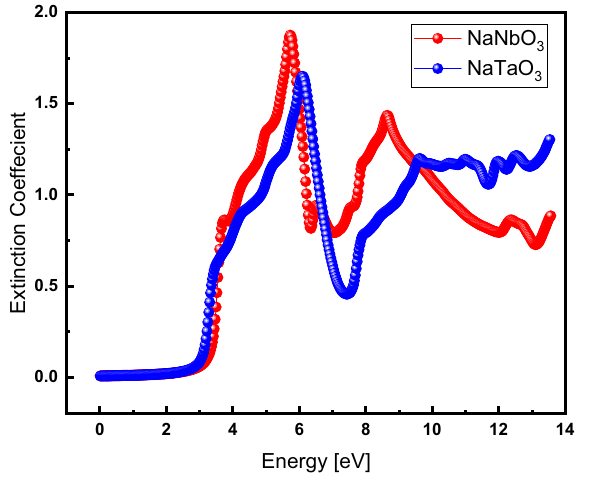
Figure 10. (Color Online) Extinction coefficient as a function of energy for NaNbO 3 (red) and NaTaO 3 (blue) oxide perovskites.